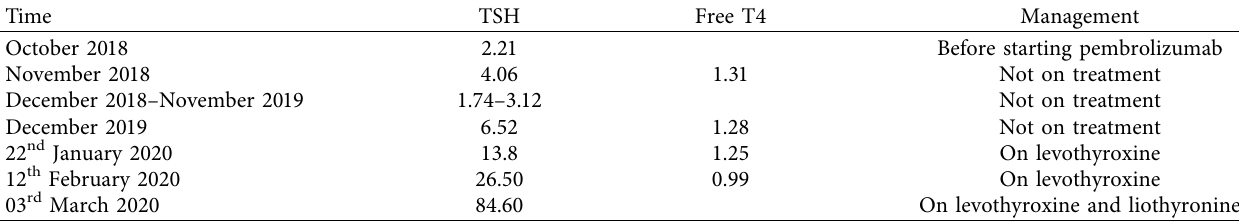
Table 1: TSH and T4 values from Oct 2018 to March